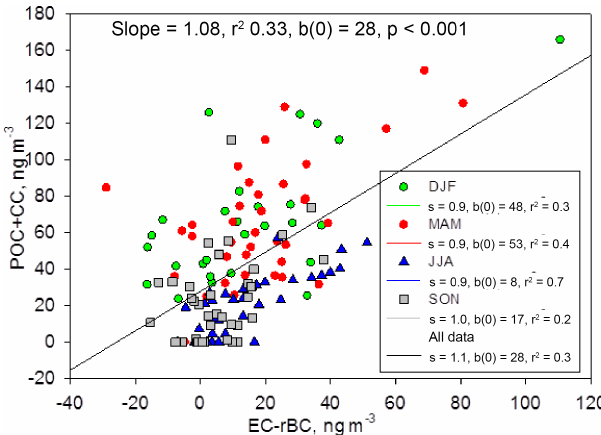
Figure 8. The weak but significant ( p <0.001) correlation among the difference between two weekly masses (EC and rBC) in Alert and the oxygenated carbon component, as represented by POC + CC, shows some positive tendency, indicating incomplete separation of EC from other co-eluting thermal components. The correlation improves for summer (blue symbol, r 2 = 0.7), indicat- ing a more consistent oxygenated source compared to other seasons where r 2 =